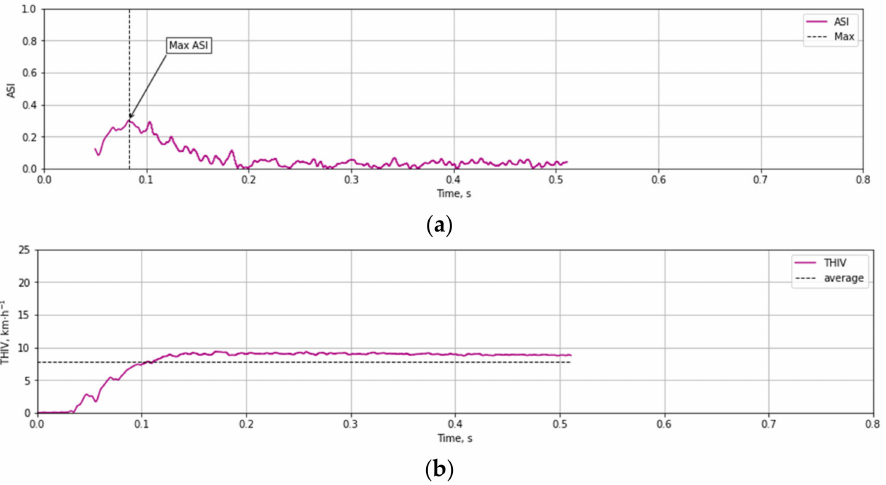
Figure 17. Numerical courses of the values of injury intensity parameters ( a ) ASI, ( b ) THIV as a result of an impact against T03 mast at 35 km/h.